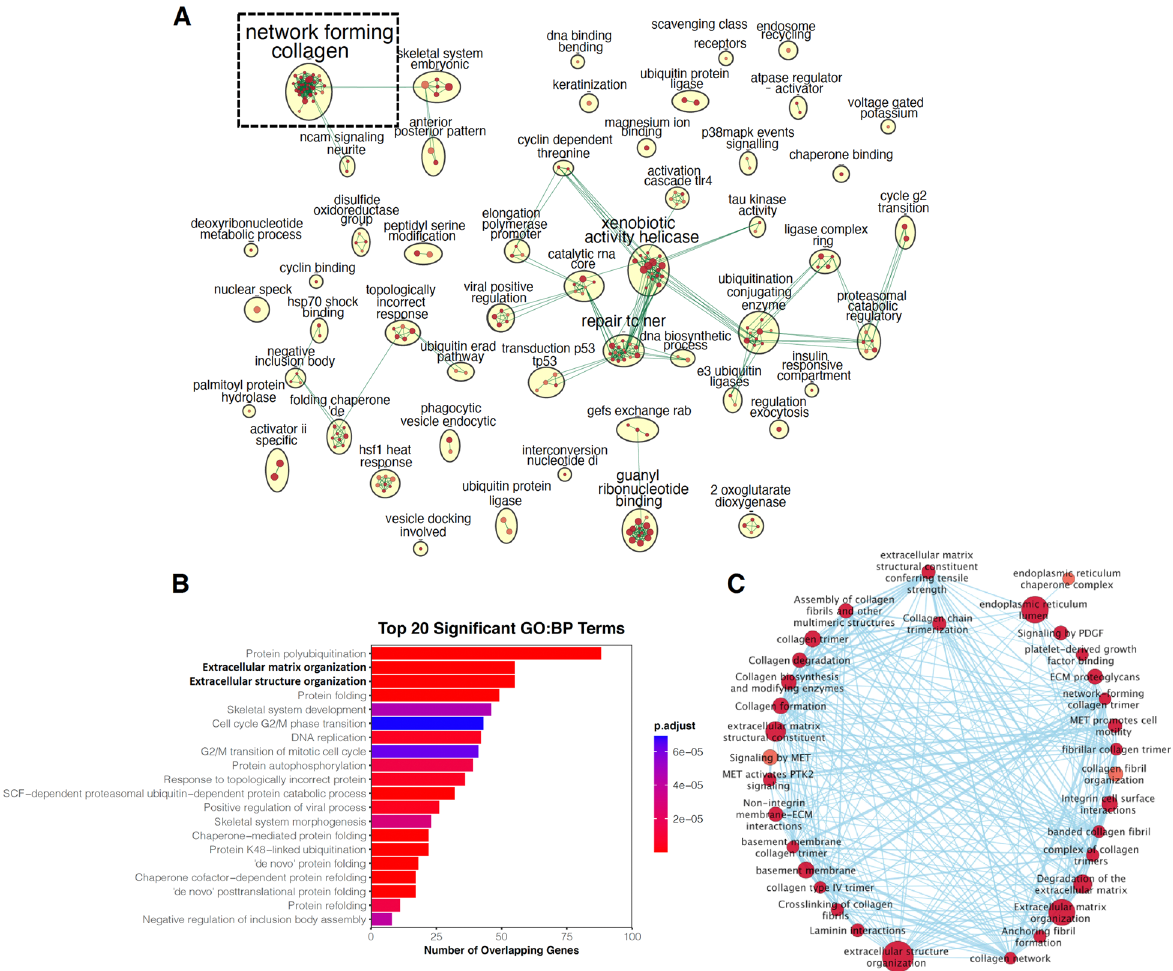
Figure 1. Comparative genomic analysis of humans and mimivirus. ( A ) Functional enriched Gene Ontology (GO) and REACTOME pathways that are shared between humans and mimivirus. We performed a genome- wide search of homologous proteins in human genome using the translation products of mimiviral ORFs as queries. This search identified 4123 unique human RefSeq records that were organized into GO and REACTOME pathways. Gene ontology networks were built based on the results from pathway analysis and visualized using Cytoscape3.8.2. Collagen related networks were highlighted with a dashed black square. ( B ) Collagen related pathways form the largest subnetwork with the most nodes. Top 20 GO enriched biological processes were shown. Collagen-related pathways are the major components of Extracellular matrix organization and Extracellular structure organization. Collagen related pathways were highlighted in bold. ( C ) Subnetwork analysis shows the organization of collagen-related